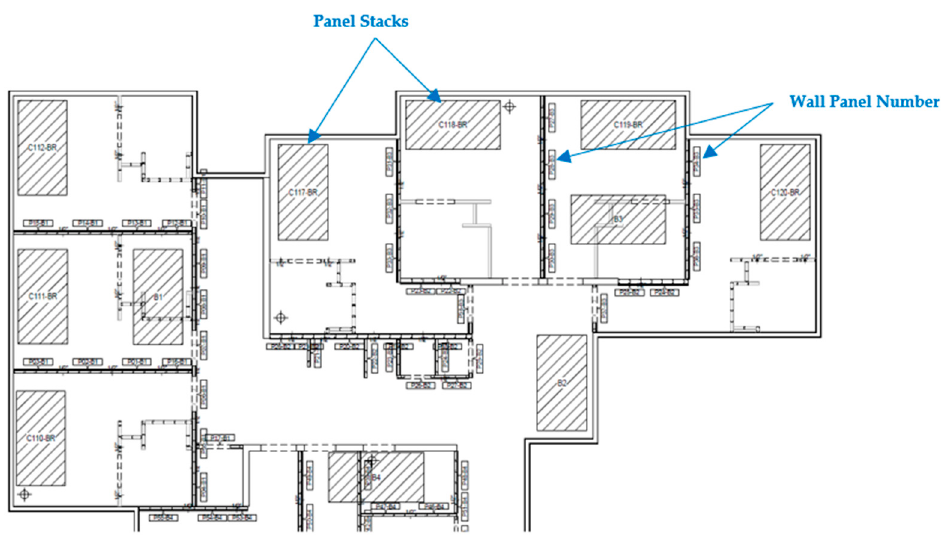
Figure 8. Example site panel stacking plan.